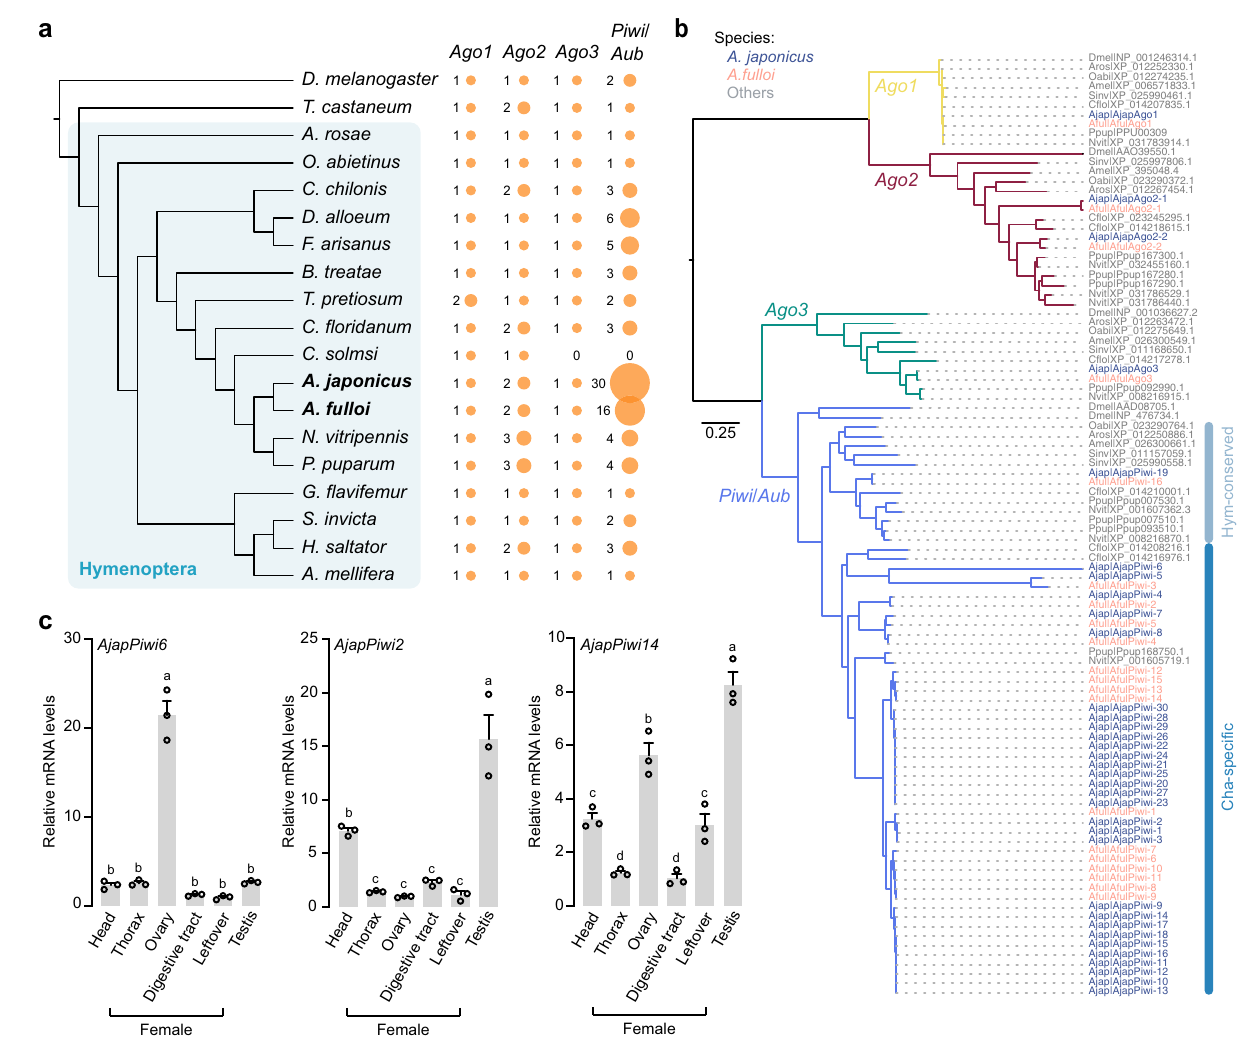
Fig. 3 | Massive Piwi expansions in the Anastatus genomes. a Key members of argonaute superfamily across 17 hymenopterans, Tribolium castaneum (Coleop- tera) and Drosophila melanogaster (Diptera). The sizes of the orange bubbles represent the number of genes of a particular family. b Phylogenetic tree of the genesfromtheArgonautesuperfamilyinninehymenopteransand D.melanogaster . CDS sequences were used for the analysis, and IQ-TREE was applied for tree con- struction with 1000 ultrafast bootstrap replicates. c qRT-PCR based gene